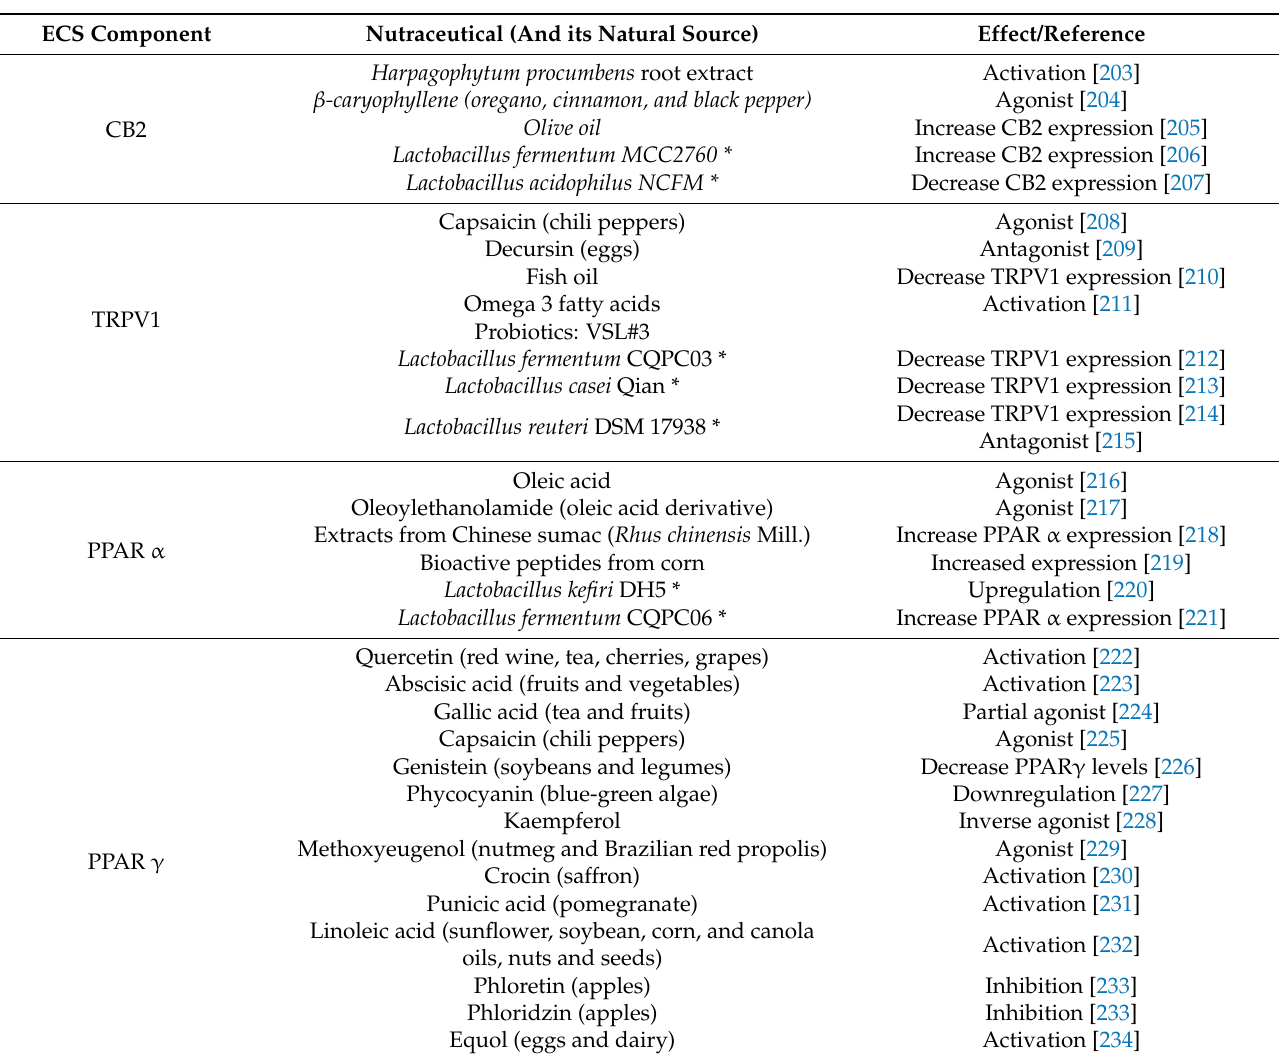
Table 3. Other nutraceuticals capable of activating or inactivating the ECS components related to the